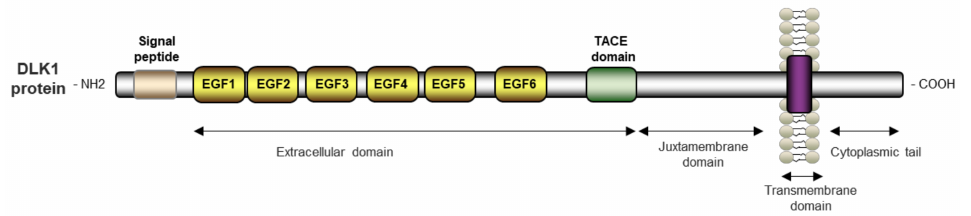
Figure 4. Schematic representation of human DLK1